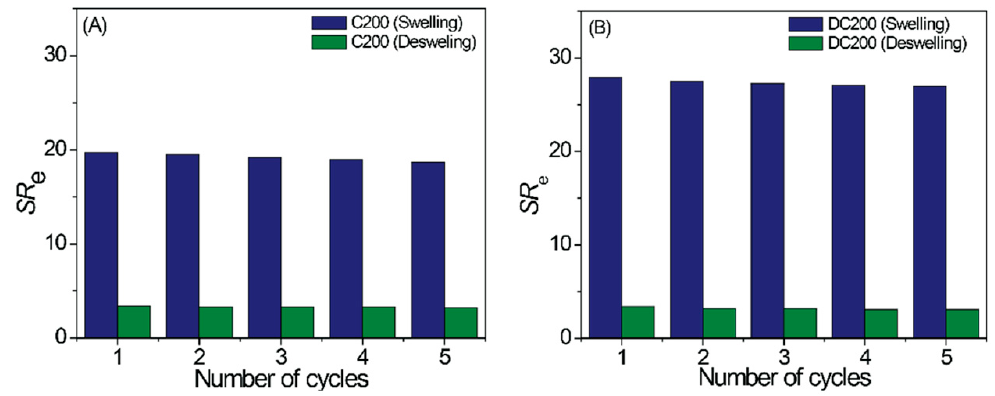
Figure A2. Swelling–deswelling cycles. ( A ) C200 in DCM. ( B ) DC200 in deionized water. Table A1. Dielectric constant ( ε ), normalized Reichardt E T values and Kamlet–Taft parameters for a selection of solvents investigated in this paper.